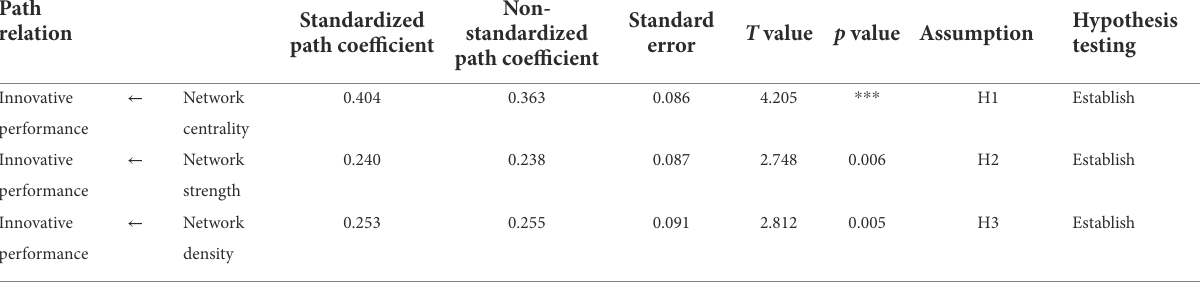
TABLE 9 Impact path